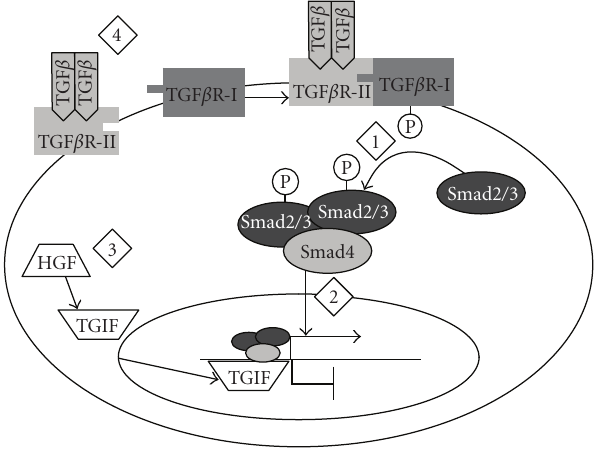
Figure 2: The TGF- β signaling pathway . Binding of TGF- β to TGF- β receptor II recruits TGF- β receptor I (TGF- β R-I). The kinase domain of TGF- β R-I phosphorylates Smad2 and 3, which form a heteromeric complex with Smad4 that translocates into the nucleus where it activates transcription of target genes. Numbers indicate points in the pathway where PPAR γ ligands have been demonstrated to interfere with TGF- β signaling. (1) GW7845, a PPAR γ ligand, inhibited Smad3 phosphorylation in human hepatic stellate cells [88]. (2) 15d-PGJ 2 inhibited nuclear translocation of Smad2/3 in rat kidney fibroblasts [84]. (3) In human renal mesangial cells, 15d-PGJ 2 induced hepatocyte growth factor (HGF), which upregulates the Smad corepressor TG-interacting factor (TGIF) [84]. (4) In mouse L929 fibroblasts, 15d-PGJ 2 or retinoic acid upregulated the phosphatase and tensin homologue deleted on chromosome 10 (PTEN), leading to repression of TGF- β 1 transcription